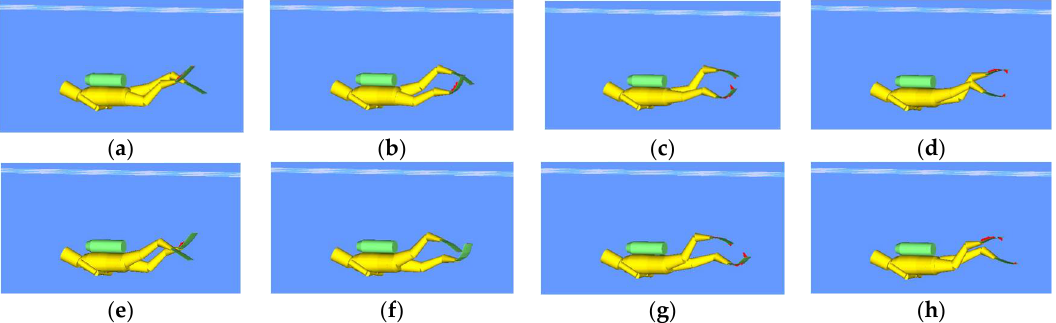
Figure 8. Animation images of the swimming motion in the simulation. Kicking cycle was 1.65 s in this case: ( a ) Time t = 0.00 s; ( b ) t = 0.21 s; ( c ) t = 0.42 s; ( d ) t = 0.63 s; ( e ) t = 0.84 s; ( f ) t = 1.06 s; ( g ) t = 1.27 s; ( h ) t = 1.48 s.